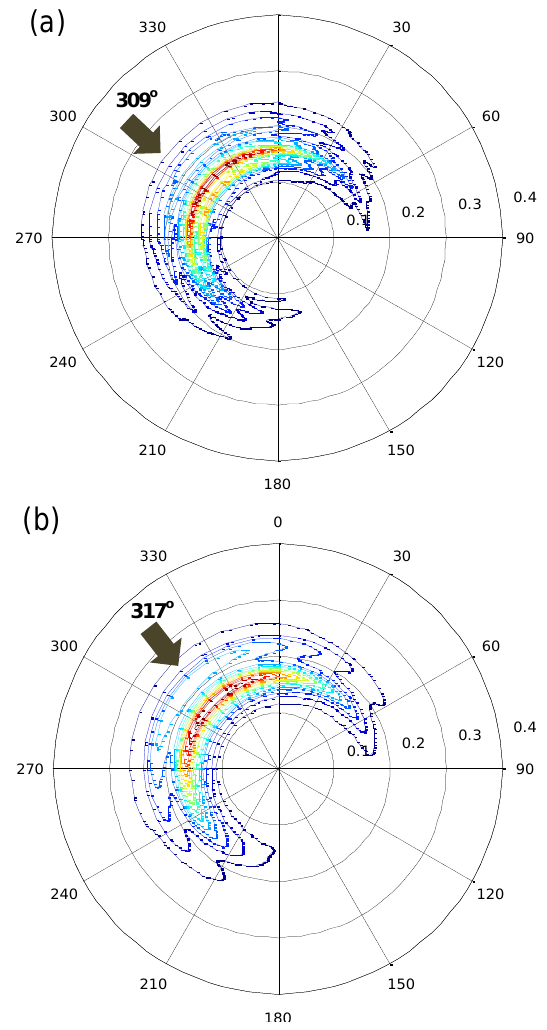
Figure 13. Comparison of the directional wave spectrum. (a) GPS-derived;